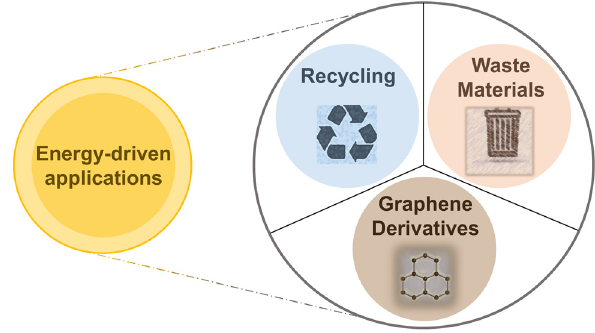
Figure 4: Recycling of waste materials into graphene nanocompo - sites for energetic